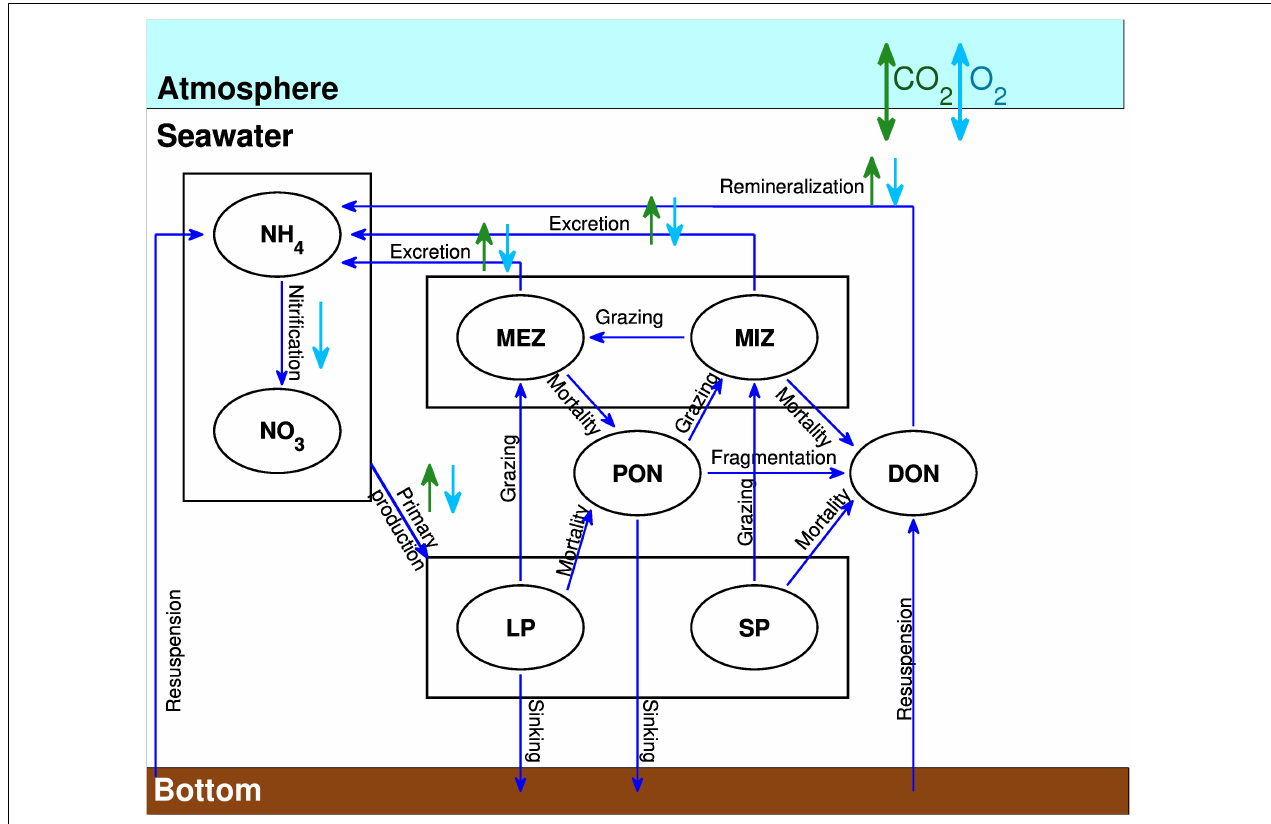
FIGURE 2 | Conceptual planktonic ecosystem model including nitrate (NO3), ammonium (NH4), large phytoplankton (LP), small phytoplankton (SP), mesozooplankton (MEZ), microzooplankton (MIZ), particulate organic nitrogen (PON), and dissolved organic nitrogen (DON). Dark blue arrows represent nitrogen fluxes between the biological components, while the light blue and green arrows denote if the represented process lead to consumption (pointed downward) or production (pointed upward) of oxygen and CO 2 ,